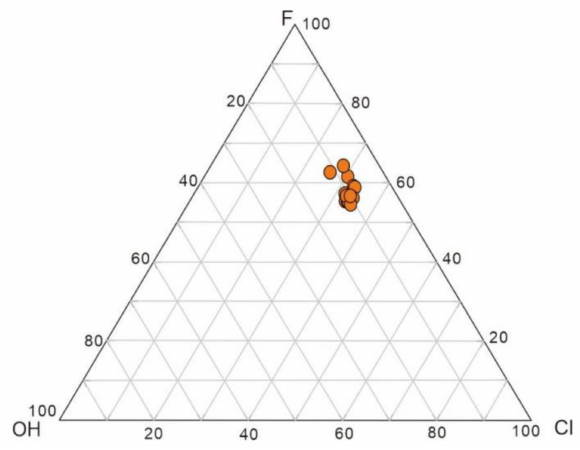
Figure 8. F–Cl–OH ternary diagram of Moroccan